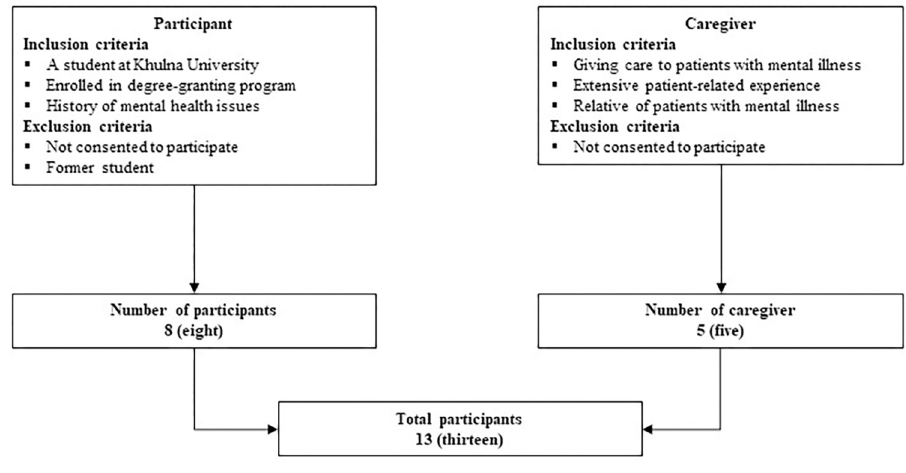
Fig 1. Selection of study